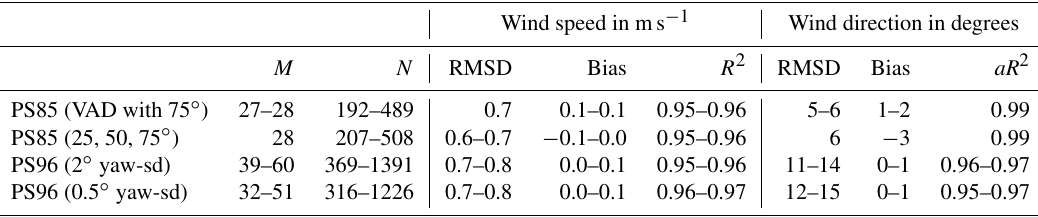
Table 3. Statistics as in Table 2 but showing the range of the statistic variables for different computations. These include all possible combinations of the following two (default marked with ∗ ): (1) the thickness of layers and thus the interpolation in height of lidar data [10, 20, 30, 40, 50 ∗ m] and (2) the time range of used lidar measurements around the radio sounding measurement (100s after start) [ ± 5, 10 ∗ , 15, 30min].